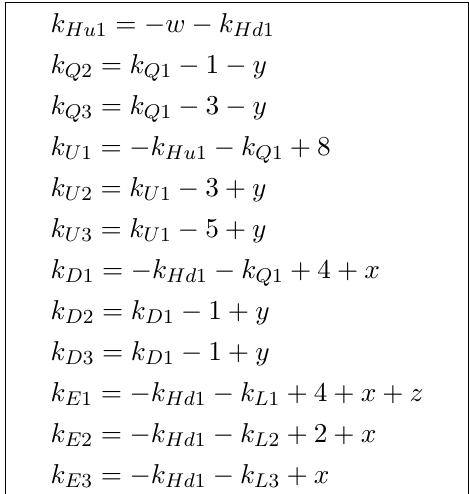
Table 3 . The constraints on the